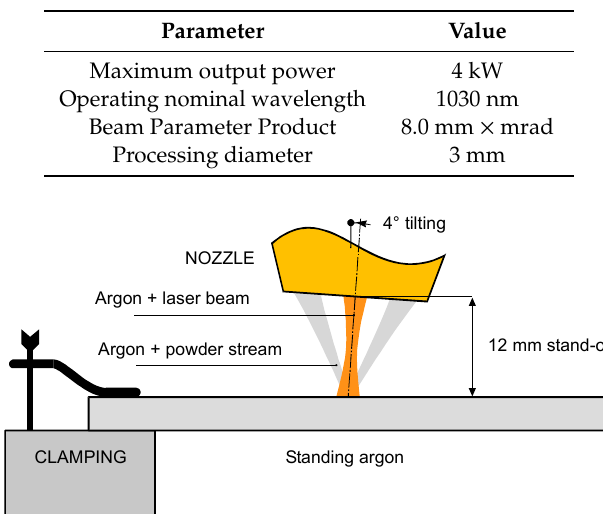
Table 1. Main features of the Yb:YAG thin disc laser source.